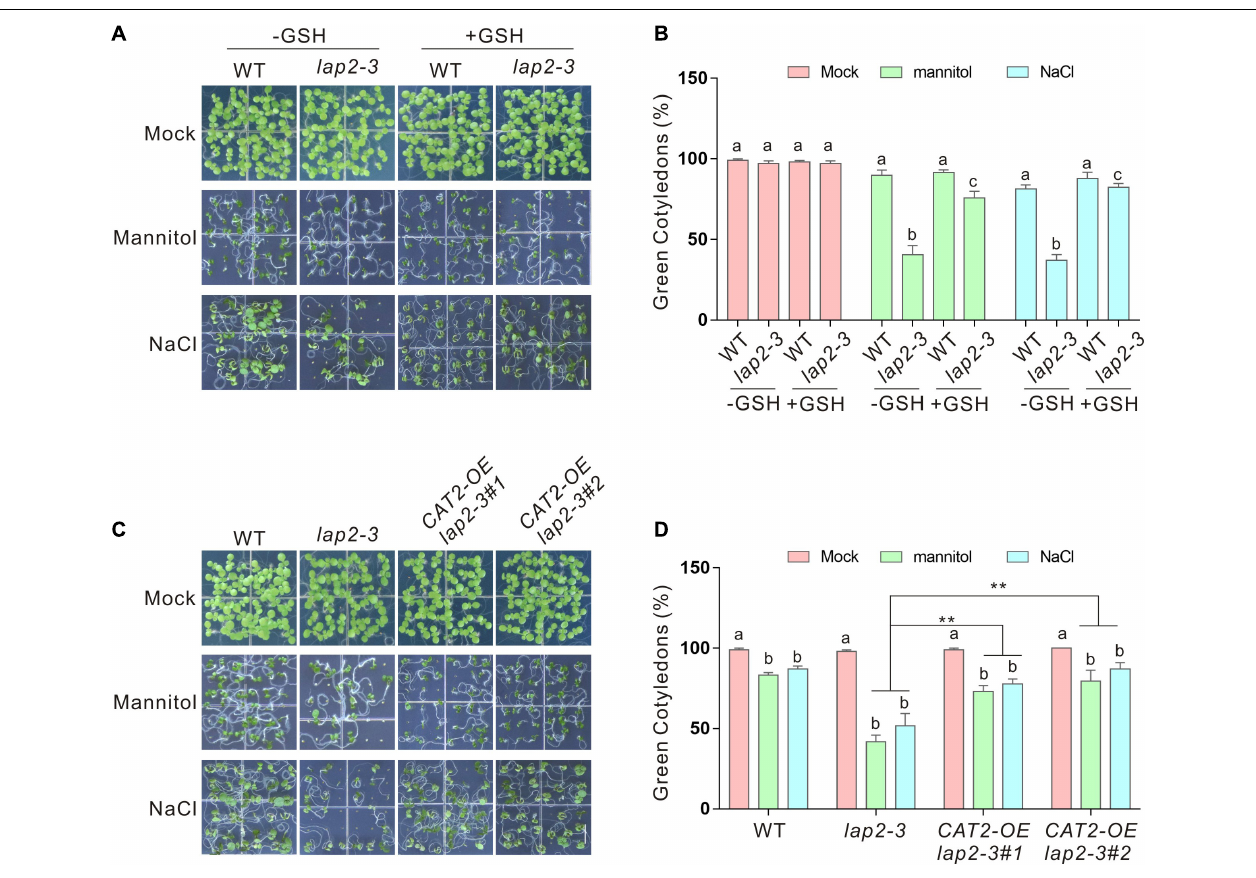
FIGURE 5 | Glutathione (GSH) or overexpressing CAT2 rescues the hypersensitivity of the lap2-3 mutant to salt or osmotic stress. (A) Images of 5-days-old wild-type and lap2-3 mutant seeds germinated on 1/2 MS medium without or with 250 mM mannitol or 125 mM NaCl in the presence or absence of 100 µ M GSH. Bars = 0.5 cm. (B) Green cotyledon percentage of the wild type and lap2-3 mutant in panel (A) . (C) Images of 5-days-old wild-type, lap2-3 , and 35S:GFP-CAT2 lap2-3 ( CAT2-OE lap2-3 ) transgenic plant seeds germinated on 1/2 MS medium without or with 250 mM mannitol or 125 mM NaCl. Bars = 0.5 cm. (D) Green cotyledon percentage of the wild-type, lap2-3 , and CAT2-OE lap2-3 plants in panel (C) . Data are means ( ± SD) of three biological replicates. Bars with different letters in the same treatment indicate significant differences at p < 0.05, revealed using one-way ANOVA with Tukey’s multiple comparison test. Asterisks indicate significant differences using Student’s t test (** p <